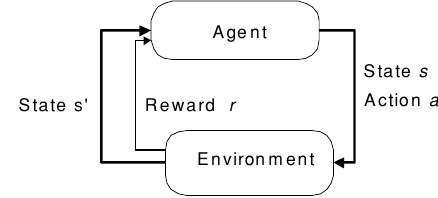
Figure 3 The Reinforcement Learning framework